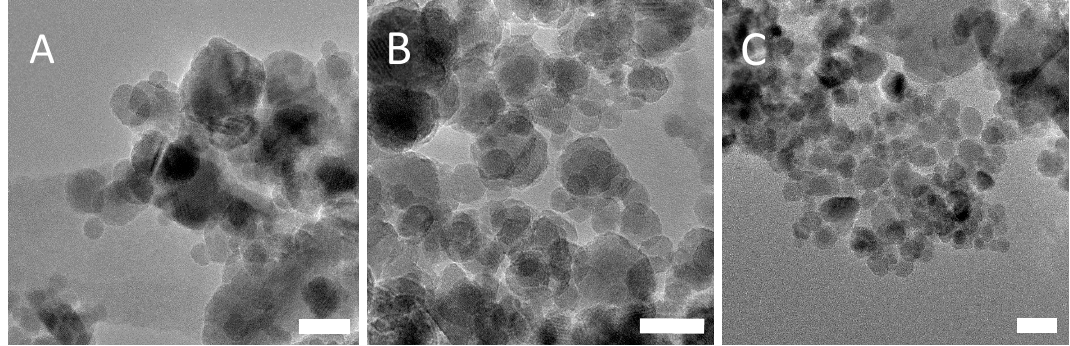
Figure 3. TEM images of PSS-stabilised Fe 3 O 4 for each concentration of PSS ( A ) 1.90 × 10 − 5 M, ( B ) 1.43 × 10 − 5 M and ( C ) 7.14 × 10 − 6 M. Scale bars correspond to 20 nm.